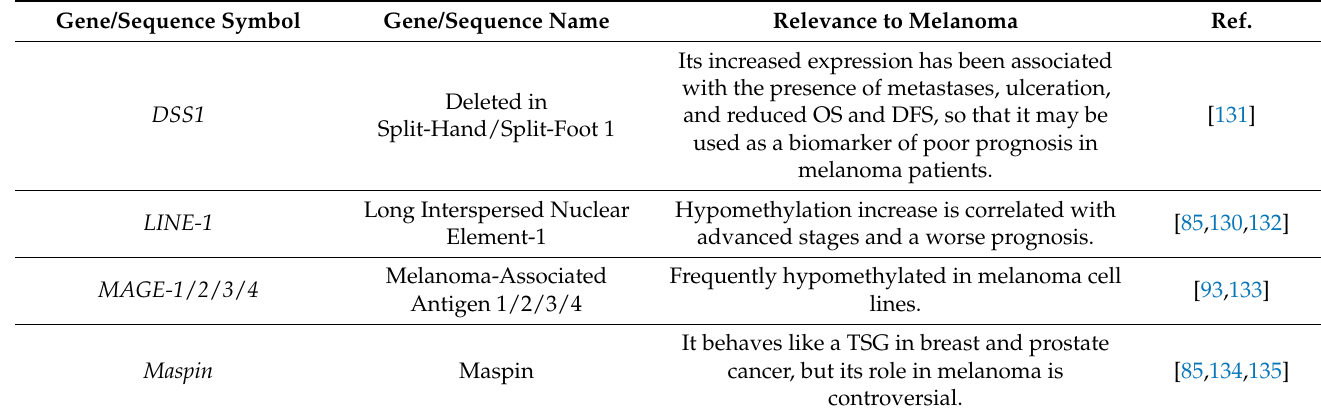
Table 2. Hypomethylated genes and sequences in